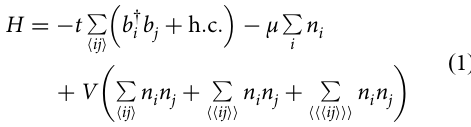
y ð b Þ ! S þ ð S (cid:2) Þ and n (cid:2) 1 = 2 ! S z , the i i i i i i